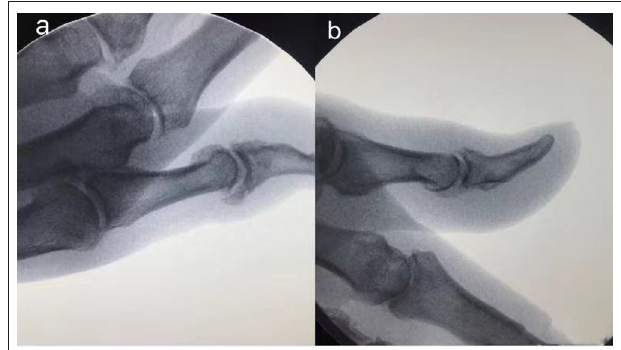
FIGURE 2 | The imaging examination of the patient before and after surgery. (a) Pre-operative X-ray showed a large number of osteophytes in the DIP joint of the thumb; (b) X-ray showed osteophyte disappeared 3 months after the operation.